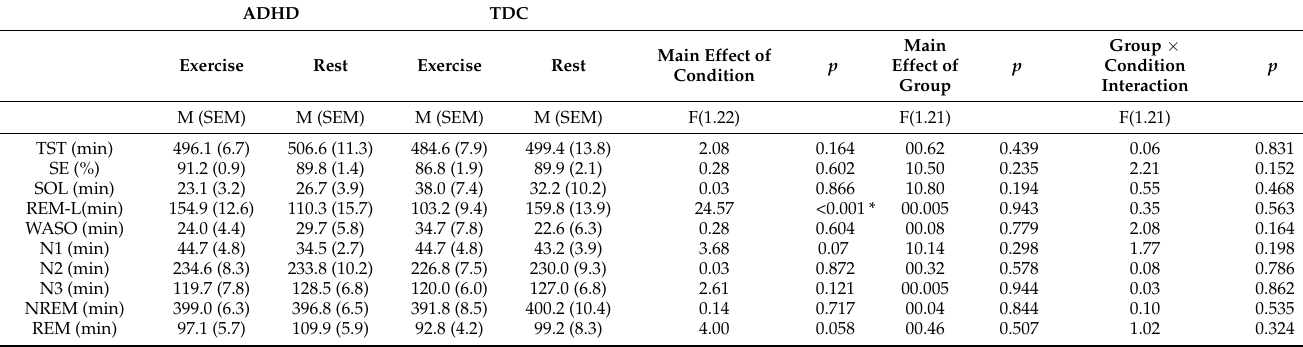
Table 2. Sleep data: means (M) and standard error of mean (SEM) of total sleep time (TST); sleep efficiency (SE); sleep onset latency (SOL); REM onset latency (REM-L); non-REM sleep stages N1, N2, and N3; total non-REM sleep (NREM); and total REM sleep (REM). * p < 0.001.